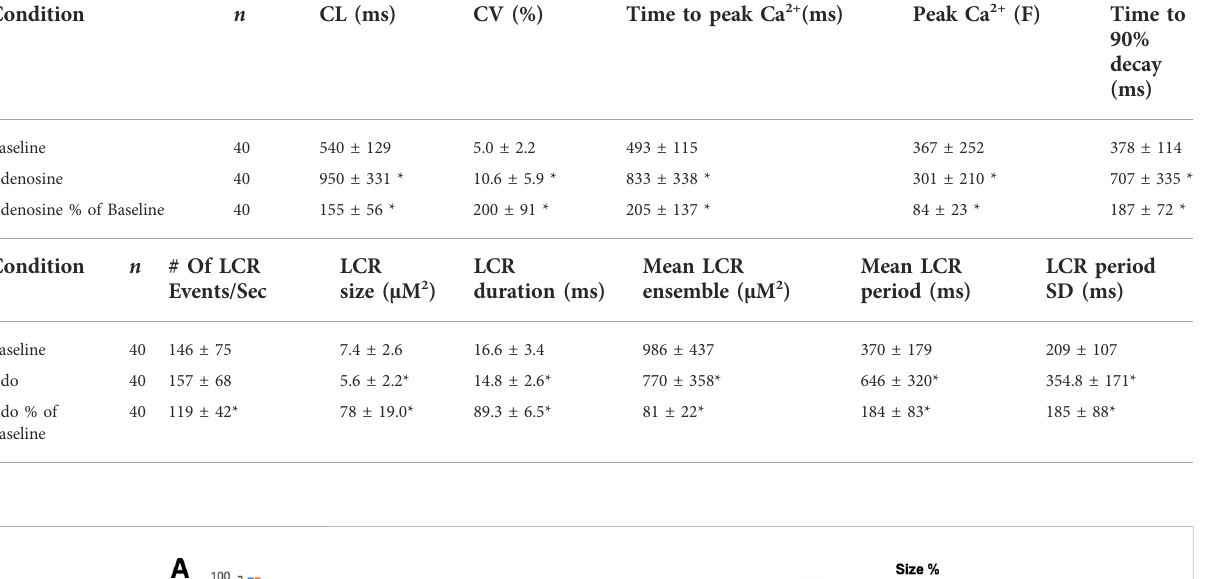
TABLE 3 Characteristics of AP-Induced Ca 2+ transient and Local Ca 2+ releases releases (LCRs) measured in this study. Ca 2+ signal measurements in SANC before and during adenosine perfusion ( n = 40). All measured cells were rhythmically fi ring at baseline. * p < 0.05, compared to baseline by two-tailed paired t test.